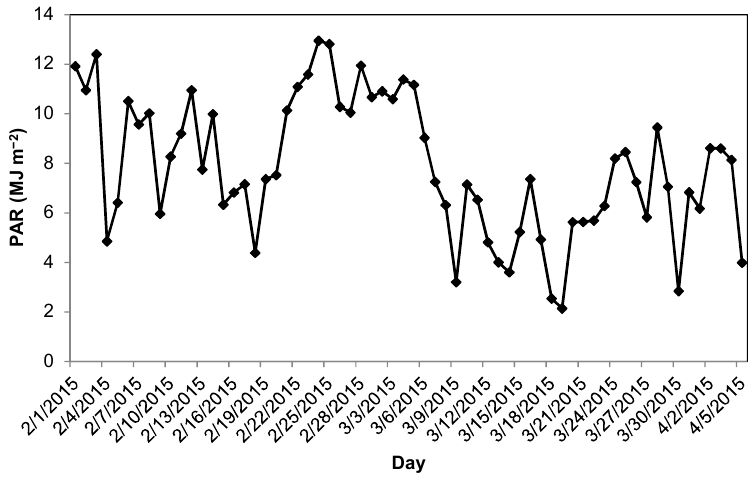
Figure 1. Daily photosynthetic active radiation registered in the greenhouse.